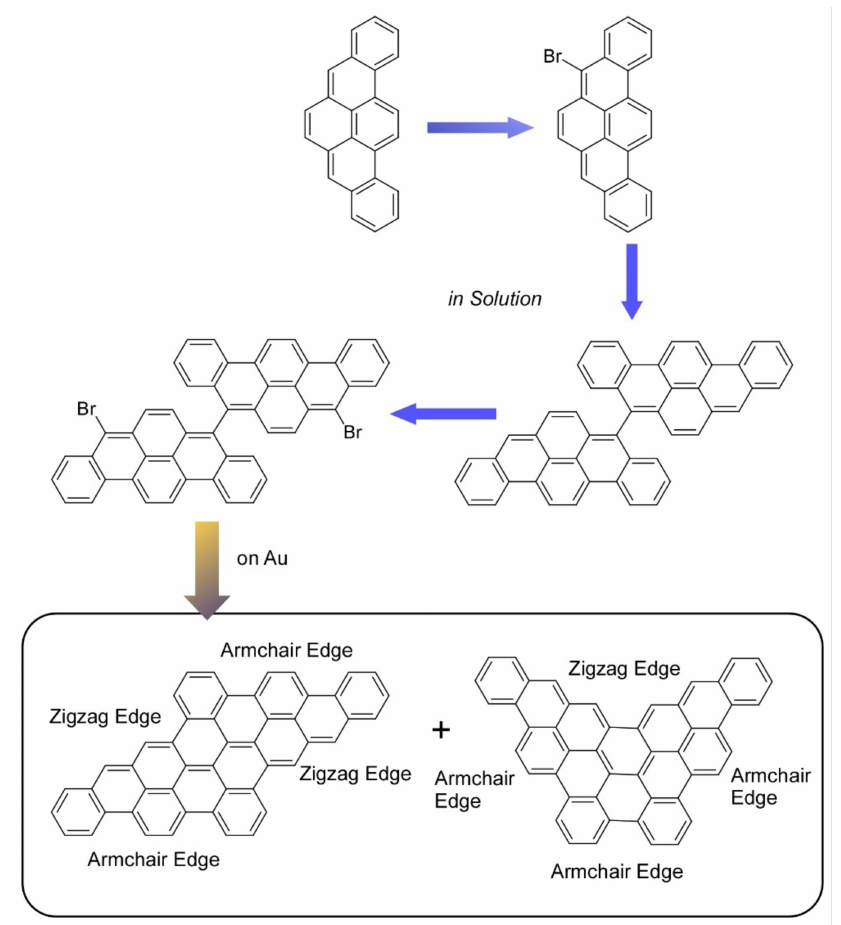
Figure 2. On-surface synthesis of two nanographenes (dibenzohexacenohexacene and dibenzopen- taphenoheptaphene), using 8,8 (cid:48) -dibromo-5,5 (cid:48) -bibenzo[rst]pentaphene as a